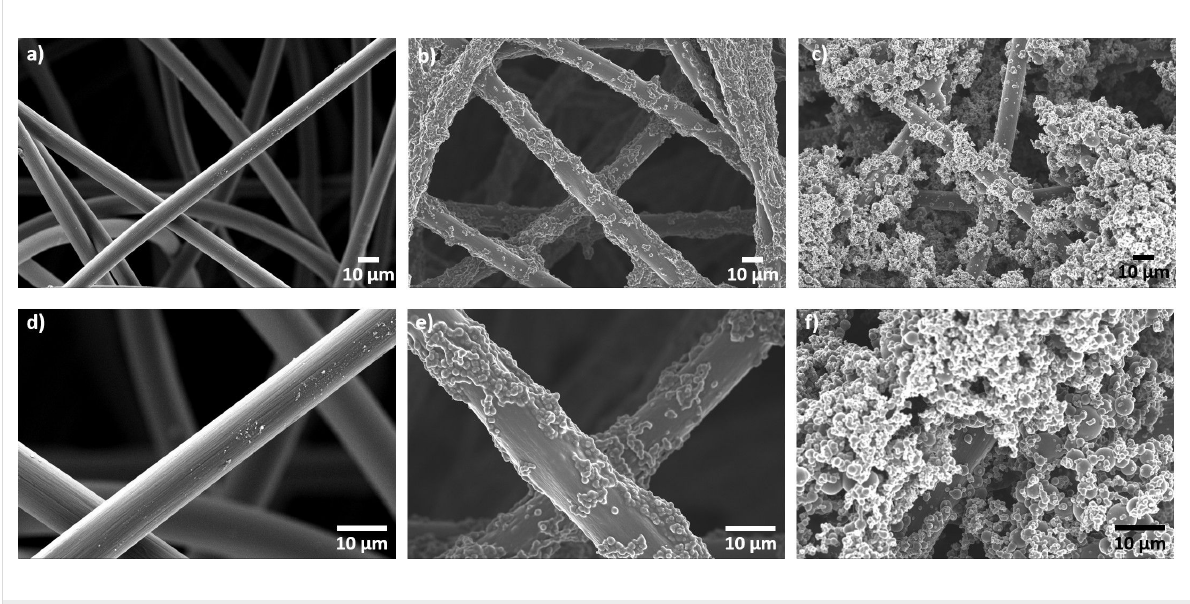
Figure 2: High-resolution images of carbonized carbon felt (left: a,d), N-doped carbon felt (middle: b,e) and S- and N-doped composite material (right: c,f) with 600× (upper row) and 1500× (bottom row) magnification.